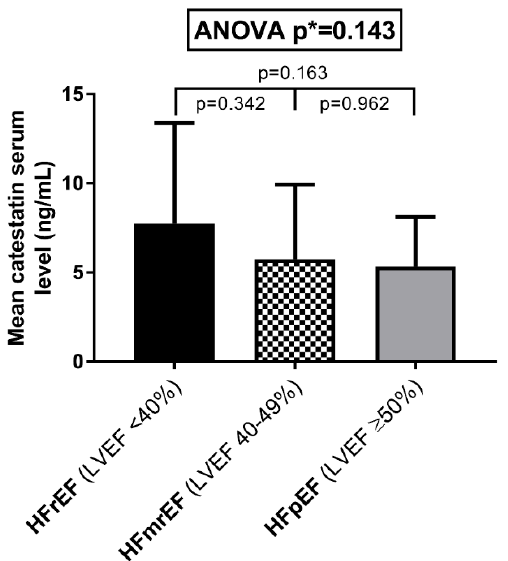
Figure 3. CST serum levels according to the left ventricular ejection fraction, stratified into three groups—heart failure with reduced ejection fraction (HFrEF), heart failure with midrange ejection fraction (HFmrEF), and heart failure with preserved ejection fraction (HFpEF).